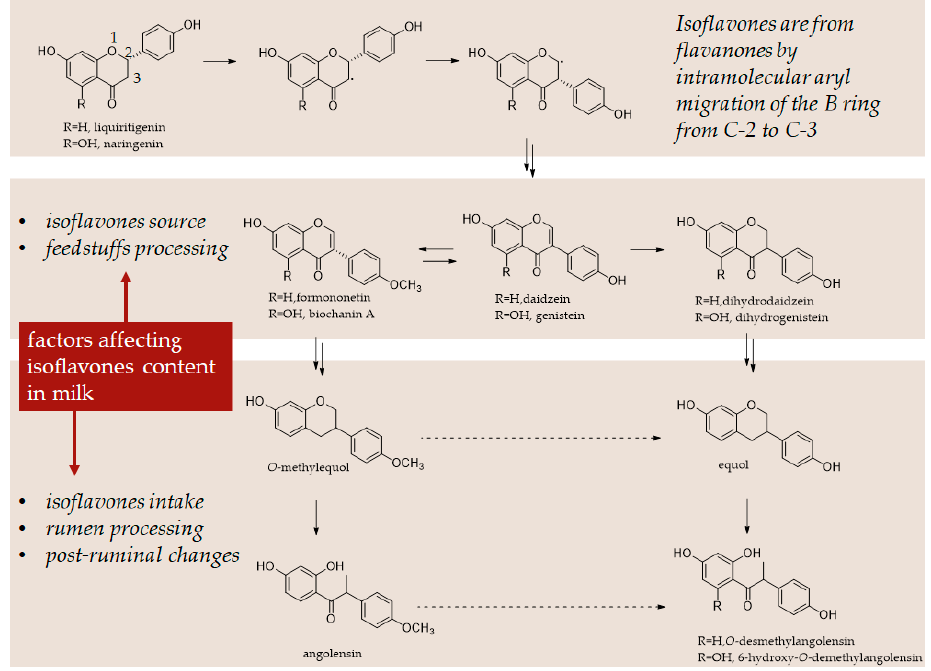
Figure 9. Isoflavone metabolism in plants and animals. The main factors affecting isoflavone content in milk are listed.